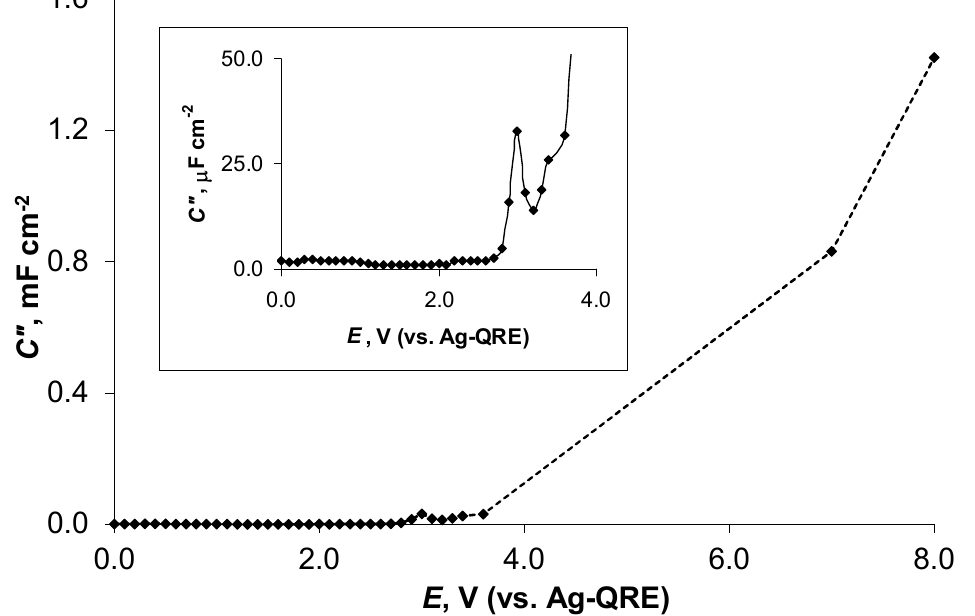
Figure 9. Imaginary capacitance ( C ′′) vs. potential ( E ) applied to the Al current collector. C ′′ values were calculated using impedance-spectroscopy data measured at the modulation frequency of 0.1 Hz.